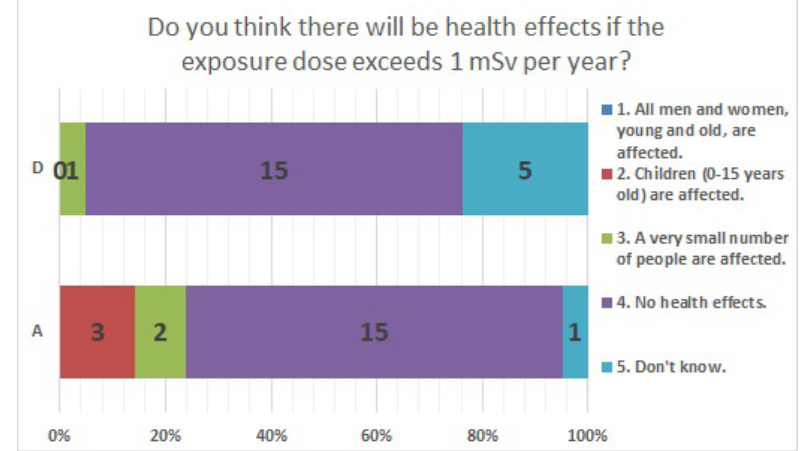
Figure 21. Responses to item No. 35.